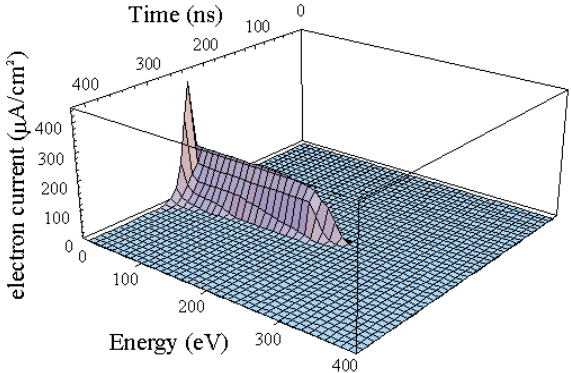
FIG. 9. (Color) Simulated cumulative energy spectrum of the electrons hitting the wall as a function of time in the PSR (the origin of time corresponds to the passage of the head of the bunch).